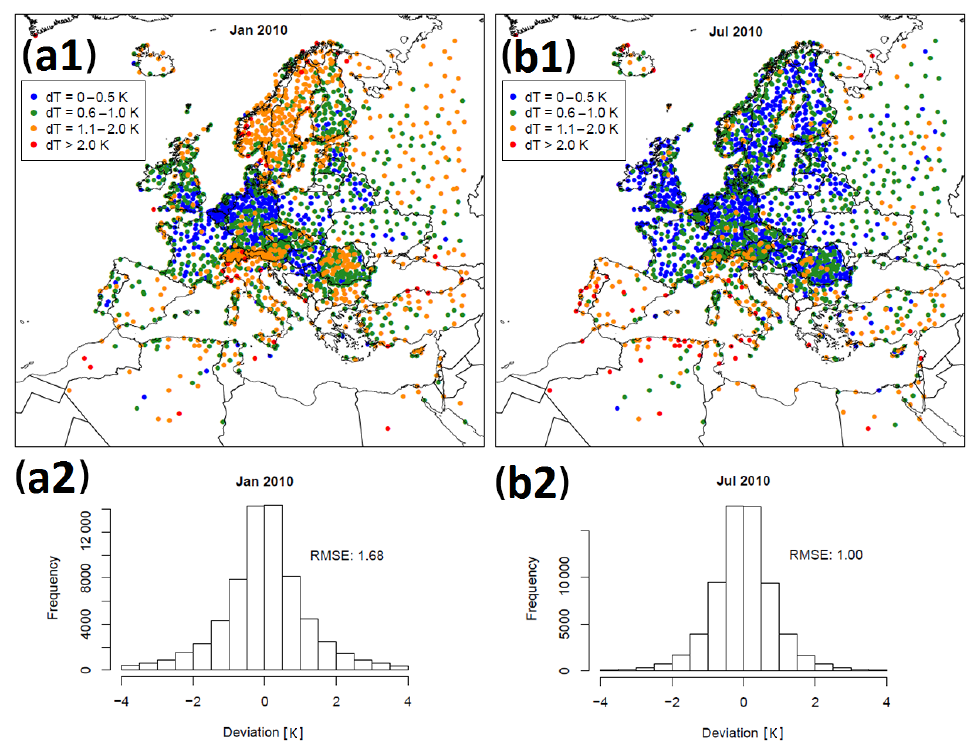
Figure 16. Cross-validation results for daily mean temperature data in January 2010 (a1, a2) and July 2010 (b1, b2) . The color code indicates the monthly mean of the daily absolute deviations. The histograms contain the full statistics of deviations over all days and